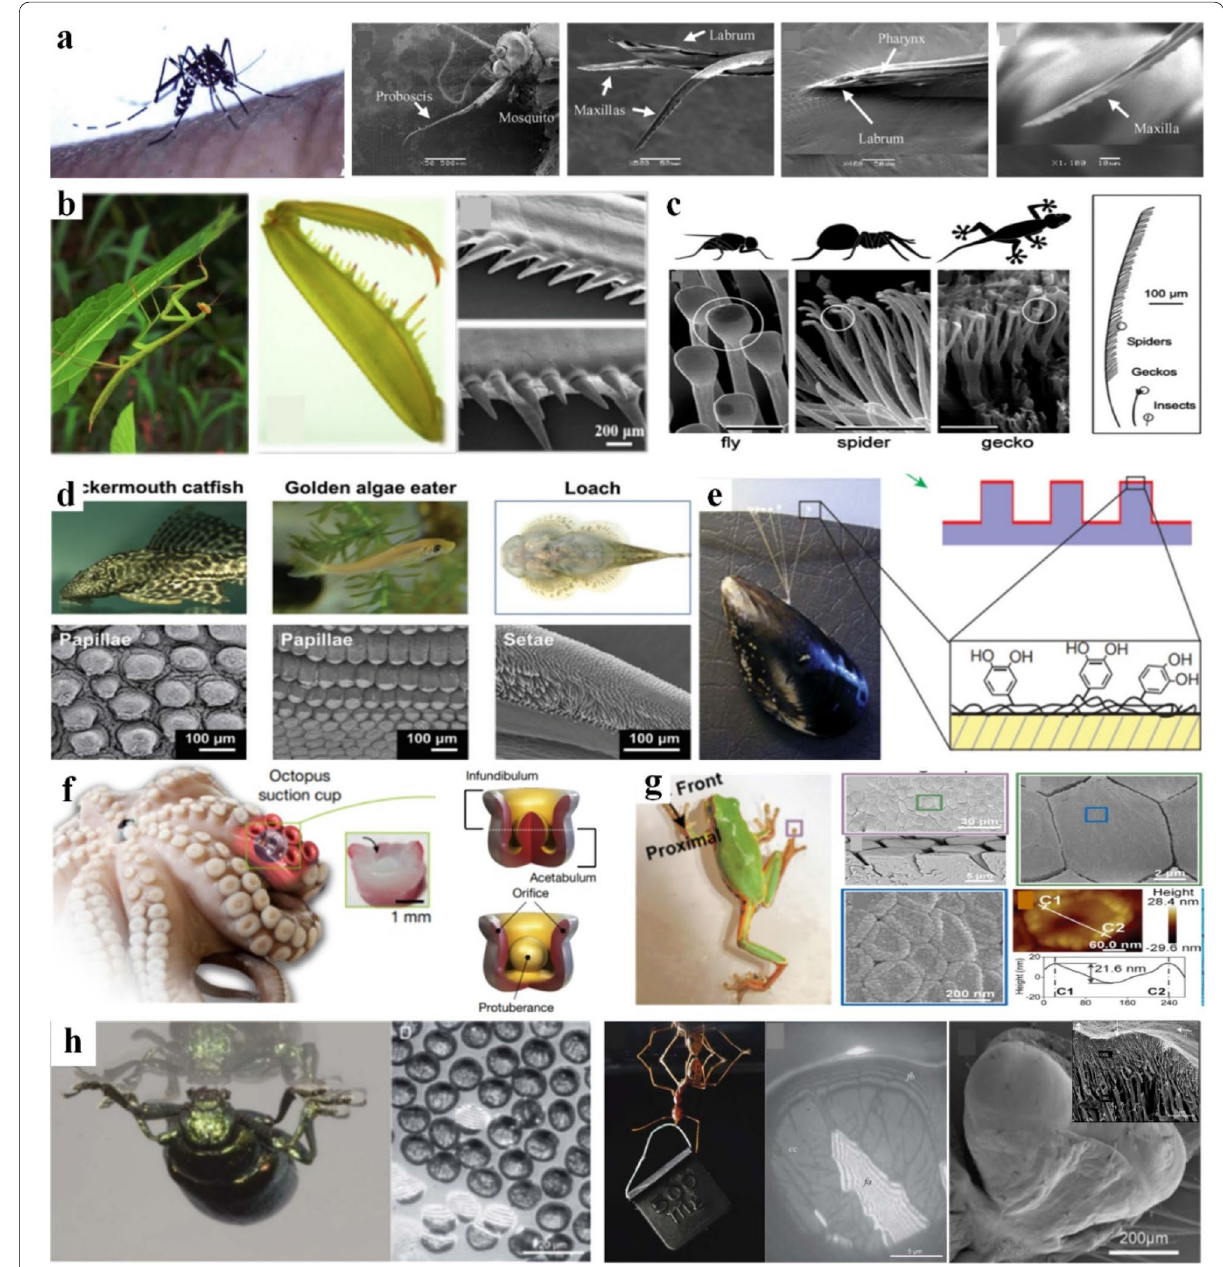
Figure 4 Strong attachment discovered on natural surfaces: ( a ) mosquito and its proboscis, ( b ) mantis and spines, ( c ) arrayed setae on insects, ( d ) strong attachments of creatures in wet environments, ( e ) mussel with its special adhesive proteins, ( f ) octopus vacuum suction, ( g ) hierarchical pillar array on the toe pad of a tree frog, and ( h ) insect adhesion with liquid